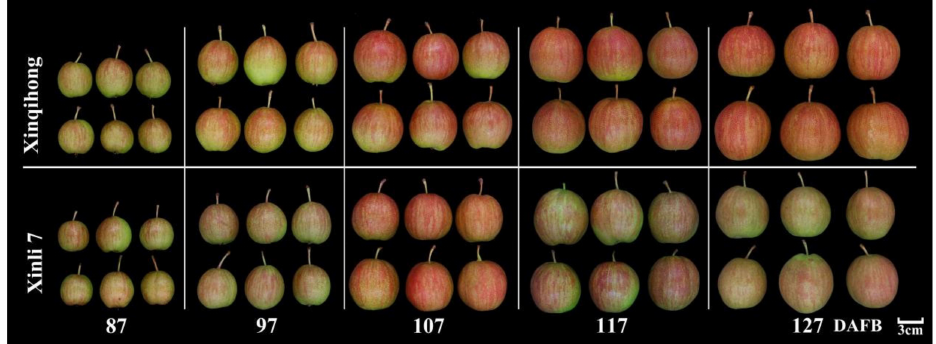
Figure 1. Phenotype of ‘Xinqihong’ and ‘Xinli 7 (cid:48) red pear varieties at different stages of fruit development. (DAFB: days after full